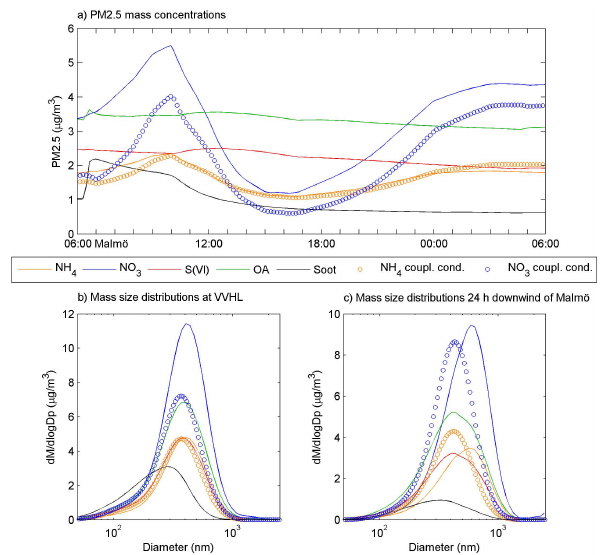
Fig. 8. (a) Modeled PM2.5 ammonium, nitrate, sulfate, organic aerosol (OA) and soot masses from 1h upwind of Malm¨o (05:00) until 24h downwind of Malm¨o. For ammonium and nitrate results are shown both from the uncoupled and coupled condensation sim- ulations. Panels (b) and (c) gives the modeled particle mass size distributions of the different compounds at Vavihill and 24h down- wind of